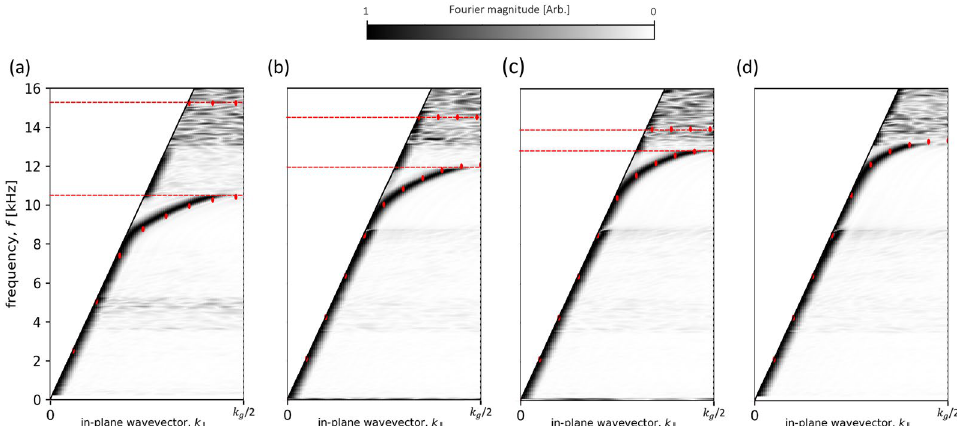
Figure 4. Experimental dispersion curves for the sample in mirror symmetry, at different separations. ( a ) h = 1.5 mm , ( b ) h = 3 mm, ( c ) h = 5 mm and ( d ) h = 10 mm. Absolute Fourier amplitude is shown as a function of frequency and in-plane wavevector k (cid:31) with the colour representing the Fourier amplitude. Data is normalised using slices in frequency. Solid lines represent the sound-line ( k 0 ) with vertical dotted lines indicating the first BZB at k (cid:31) = k g / 2 . Red points show eigenfrequency predictions from loss-inclusive numerical models. Red dashed lines represent formed bandgaps.